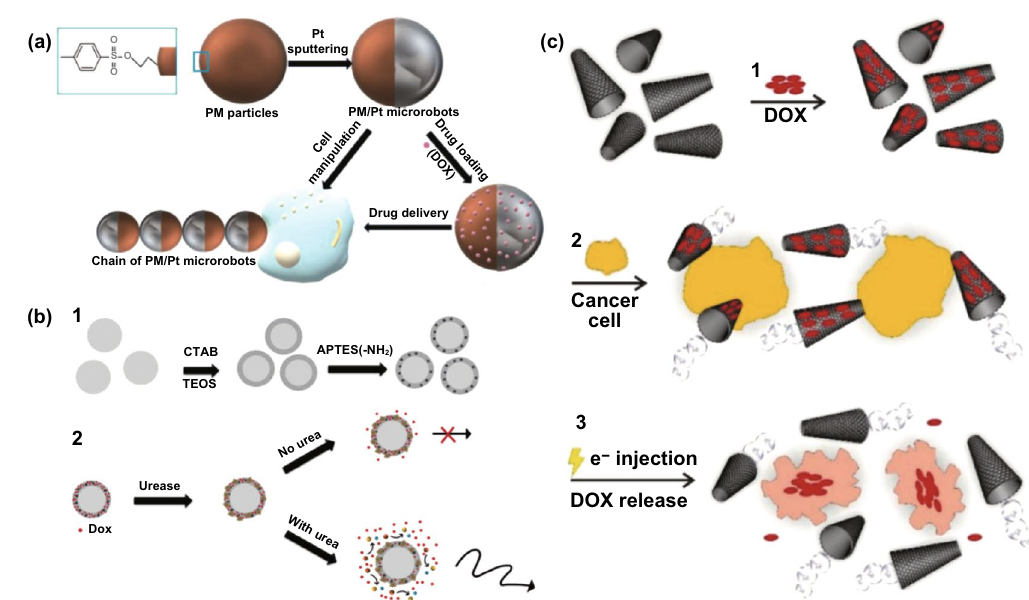
Fig. 2 a Schematic illustration of the fabrication of PM/Pt microrobots for cell manipulation, anticancer doxorubicin (DOX) drug loading, and delivery. Adapted from Ref. [61] with permission, copyright Wiley Ltd., 2018. b Enzyme-powered nanobots enhance anticancer drug deliv- ery. Adapted from Ref. [62] with permission, copyright Wiley Ltd., 2017. c An overview on the loading and release of doxorubicin on/from n-rGO/Pt micromachines. (1) Physical adsorption of doxorubicin on the outer layer of micromachine (n-rGO). (2) Bubble-propelled swimming of micromachines loaded with doxorubicin in the presence of cancer cells (yellow). (3) The release of doxorubicin upon applying an electrical potential and delivering the drugs to the cancer cells. Adapted from Ref. [63] with permission, copyright Wiley Ltd., 2019. (Color figure